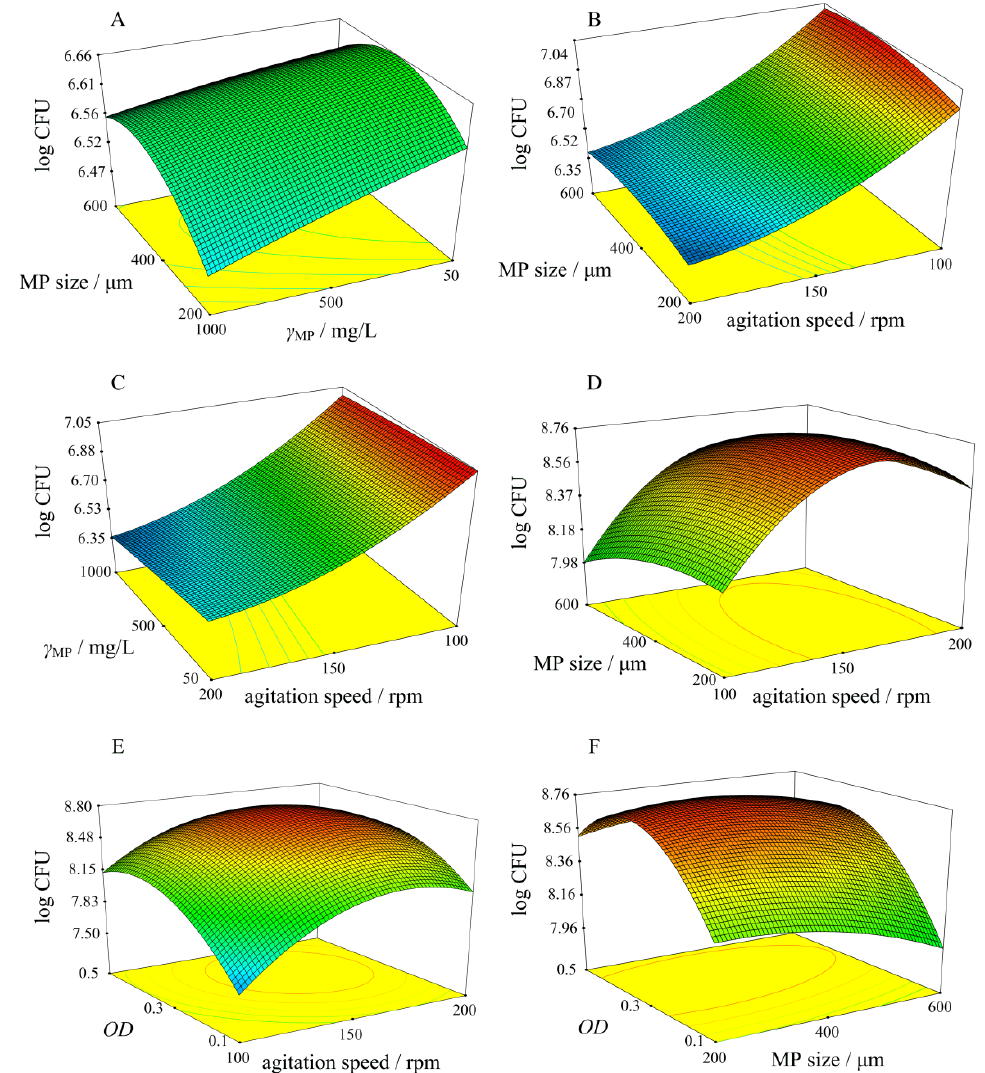
Figure 6. Response surfaces obtained for MP-PS biodegradation by Bacillus cereus ( A – C ) and by Pseudomonas alcaligenes ( D – F ) in main experiments by full factorial design. Table 5. ANOVA analysis for obtained models for MP-PS biodegradation by Bacillus cereus and Pseudomonas alcaligenes .